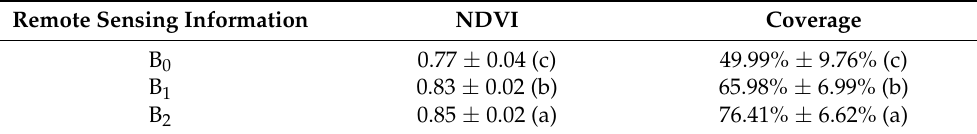
Table 2. Average NDVI and coverage of winter wheat under different basal fertilizer levels.